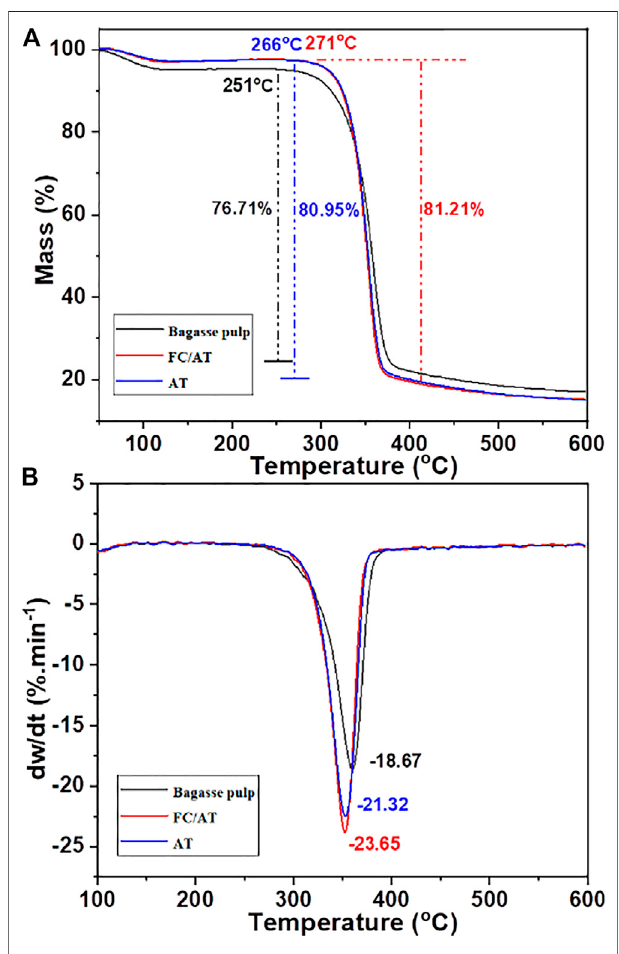
FIGURE 8 | TGA (A) and DTG (B) of bagasse fi ber with different treatments.